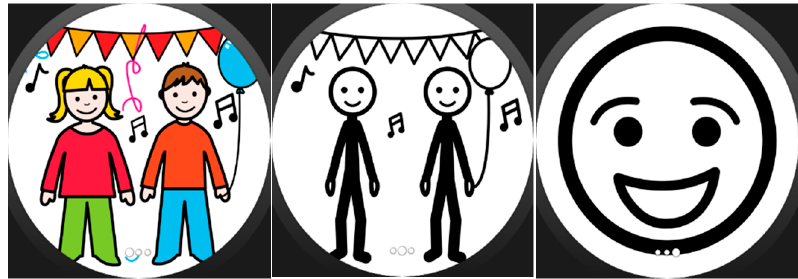
Figure 2. Sequence of pictograms in the smartwatch screen.